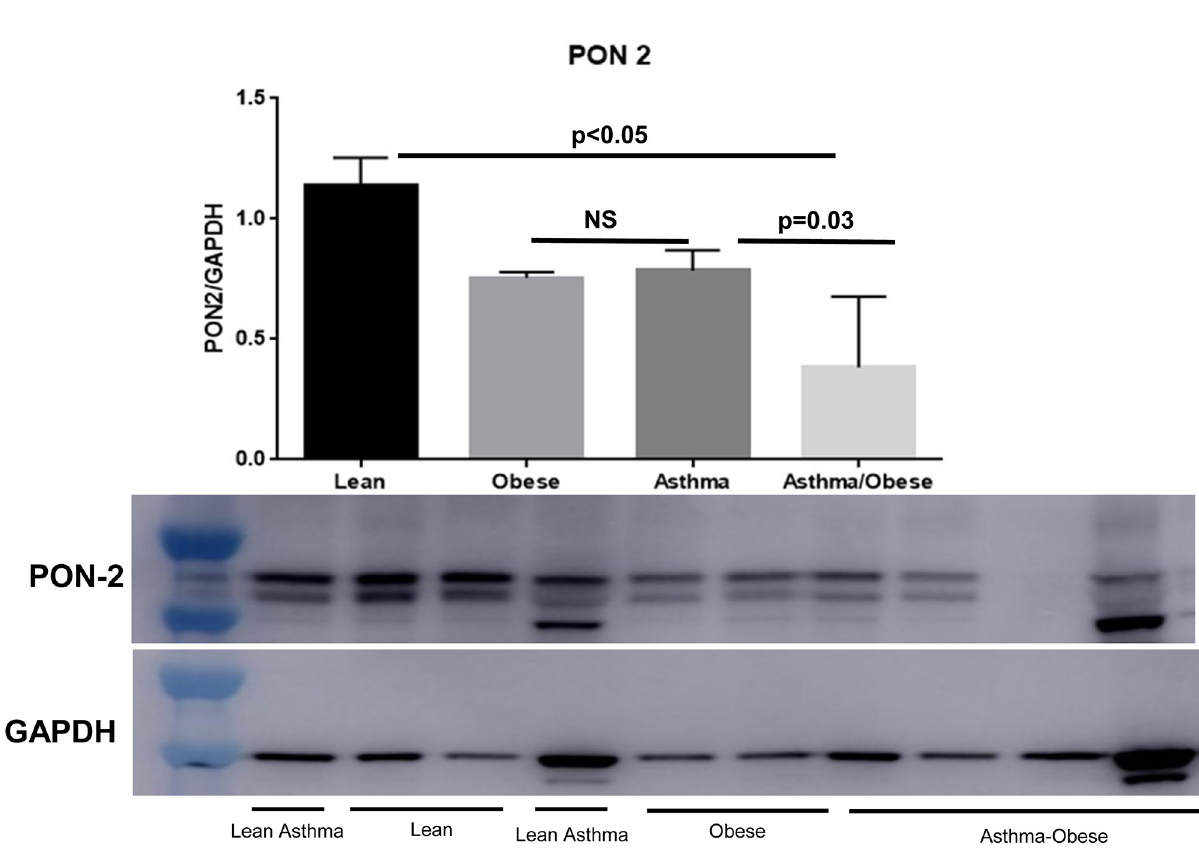
Fig 1. PON2 protein levels in human bronchial epithelial cells from obese and non-obese asthmatics and control subjects. Human bronchial epithelial cells from obese-asthmatics subjects had the lowest PON2 levels when compared with healthy controls. Densitometry of PON2 � p < 0.05, N = 4/group one-way